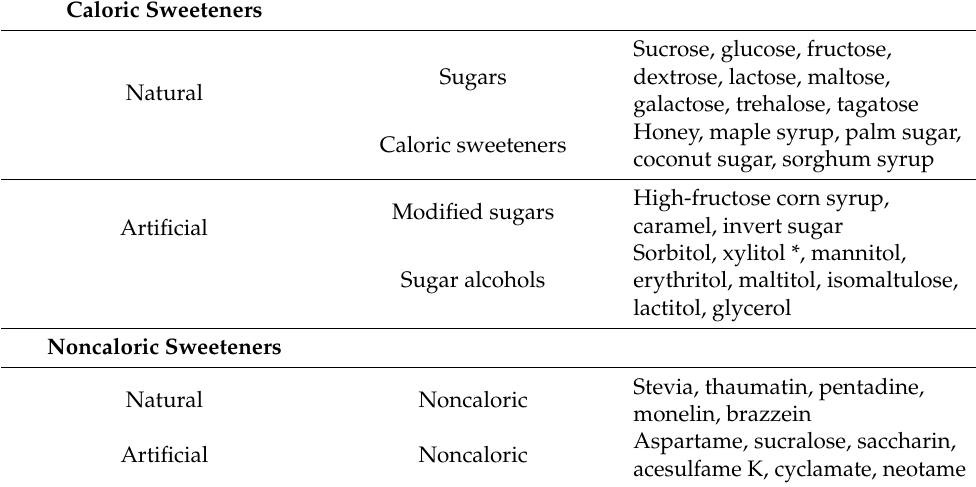
Table 1. Sweeteners’ classification (retrieved and modified from